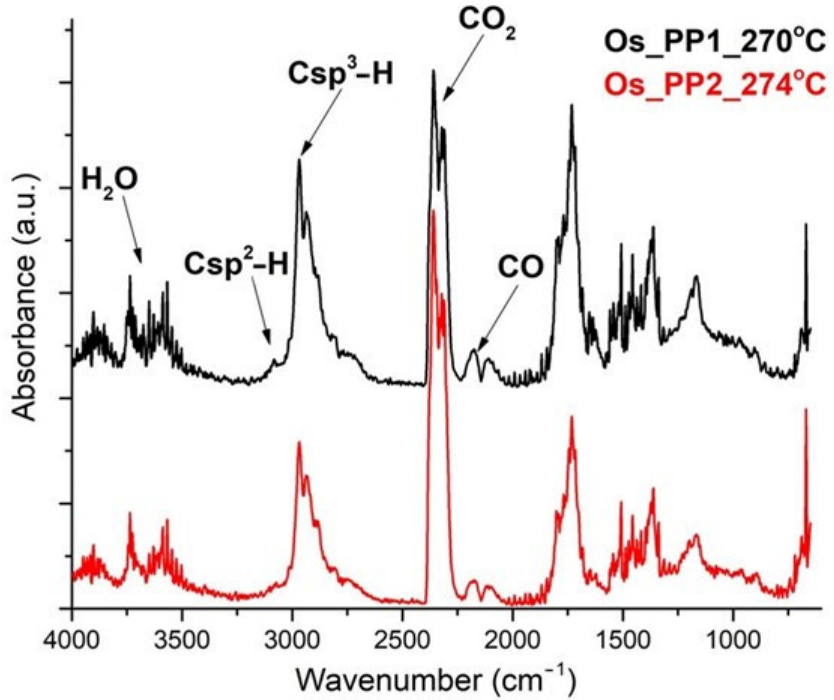
Figure 12. FTIR spectra of evolved gases at 270 °C for Os-PP1, and at 274 °C for Os-PP2.